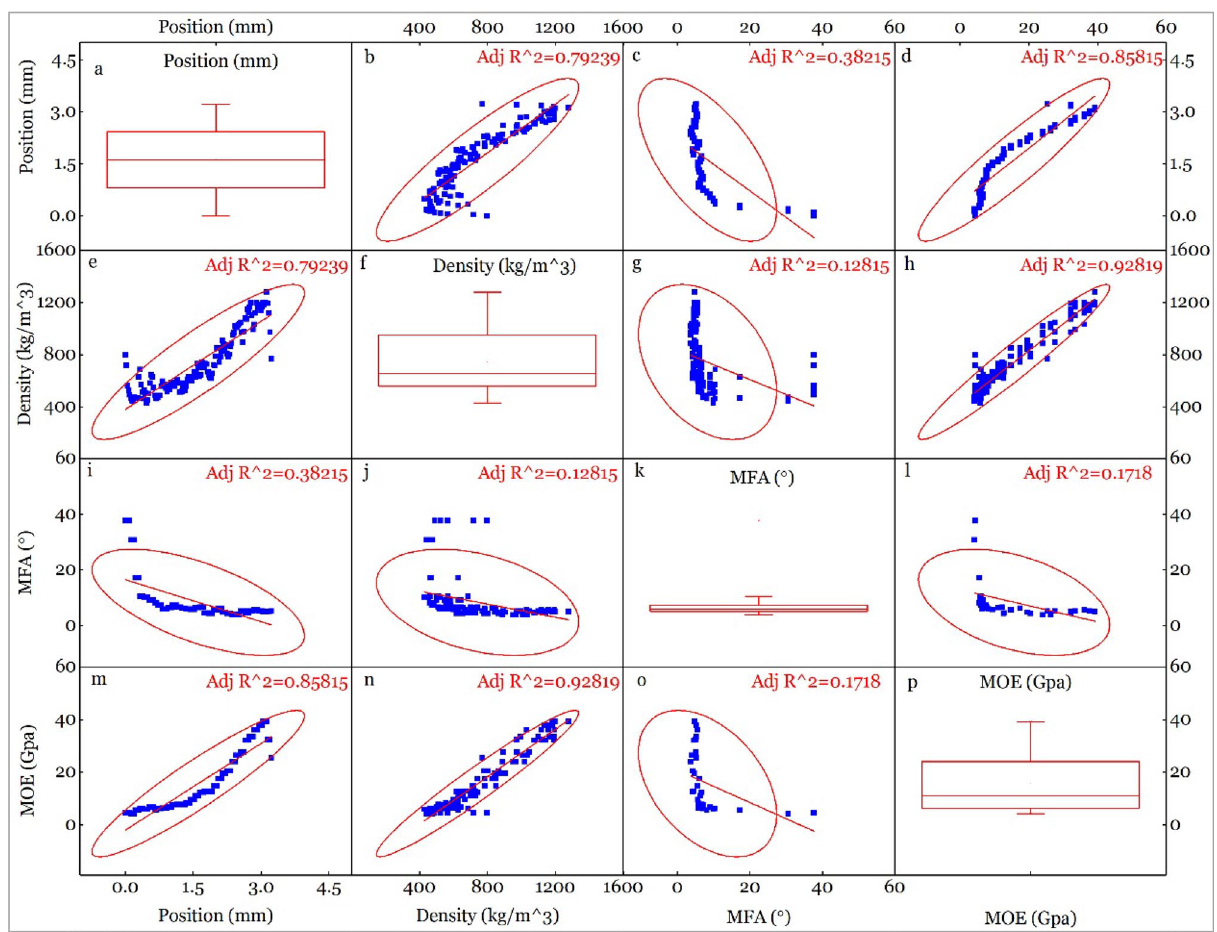
Figure 8. Correlation between position, density, MFA and MOE of tension